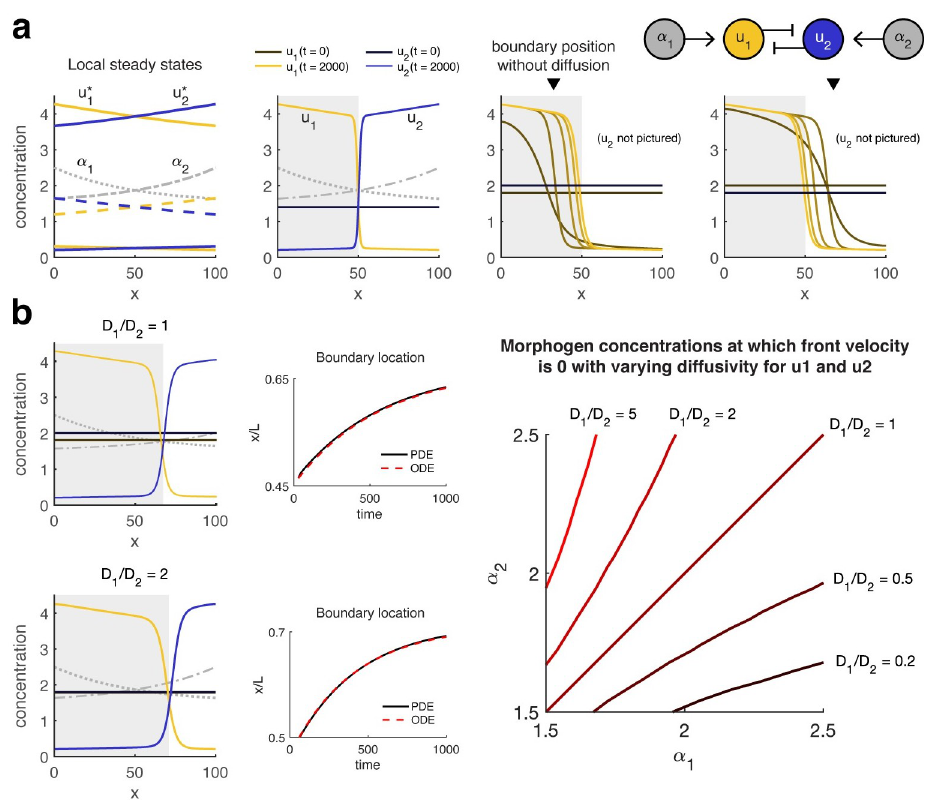
Fig 5. (a) Diffusion permits a bistable gene expression boundary to be accurately placed independently of initial conditions . Left, bifurcation diagram and right, simulation results for Eq (19) with a = 1.7, β = 0.35, D 1 = D 2 = 1, n n r = 2, K a = 0.75, K r = 1, and α 1 ( x ), α 2 ( x ) as shown. Gray shaded region indicates rightward propagation of the front in u 1 (gold) and leftward for the front in u 2 (blue), with lighter shades indicating later time points. Regardless of the initial condition, the boundary propagates toward the point where the toggle switch is “balanced” (the local steady states are such that u � ¼ u � ). Inverted black triangle indicates the position of a gene expression boundary with the same initial 1 2 conditions when gene products do not diffuse. For clarity, only u 1 is pictured in the third and fourth plots. (b) Imbalance in gradients or diffusivities may shift the location of the boundary . Right, when D 1 = D 2 (top), the boundary localizes where α 1 ( x ) = α 2 ( x ). Letting D 1 = 2 = 2 D 2 (bottom) shifts the localization point in favor of higher u 1 . Middle, ODE approximations from the time of boundary formation produce an error less than 0.5% embryo width in predicting boundary location. Simulations are shown for � = 0 ( D 1 = D 2 ) or � = − 0.5 ( D 1 = 2 D 2 ). Right, changing the diffusion ratio shifts the nullcline for front velocity toward lower concentrations of the faster-diffusing species. Decreasing the diffusivity also decreases the width (increases the steepness) of the respective front (S2